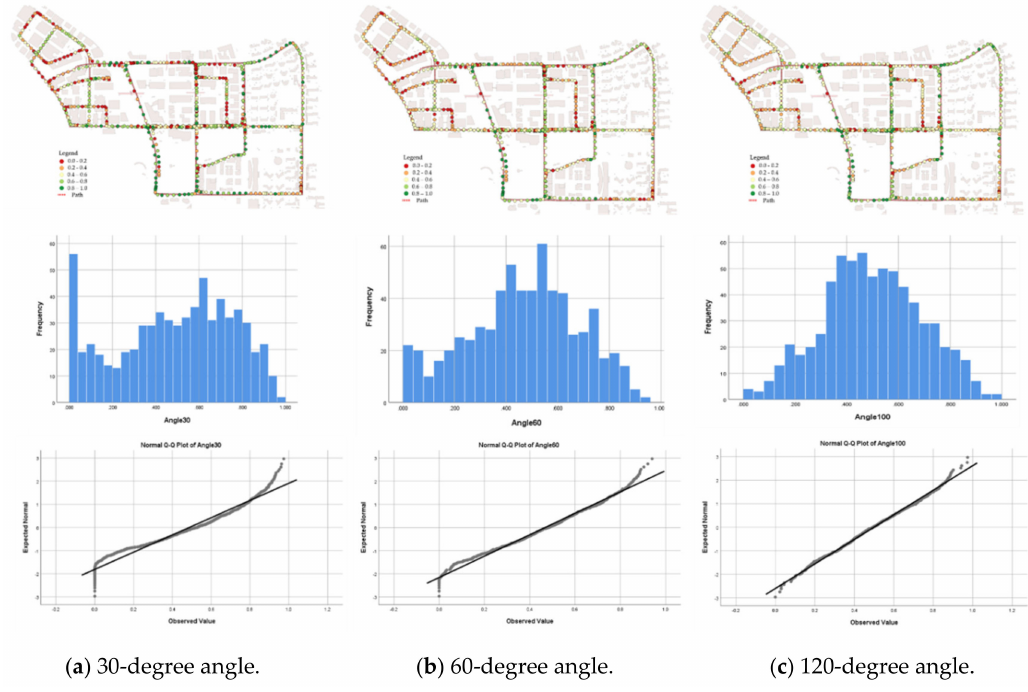
Figure 9. VPD results at 30-, 60-, and 120-degree angles. Table 1. Test of